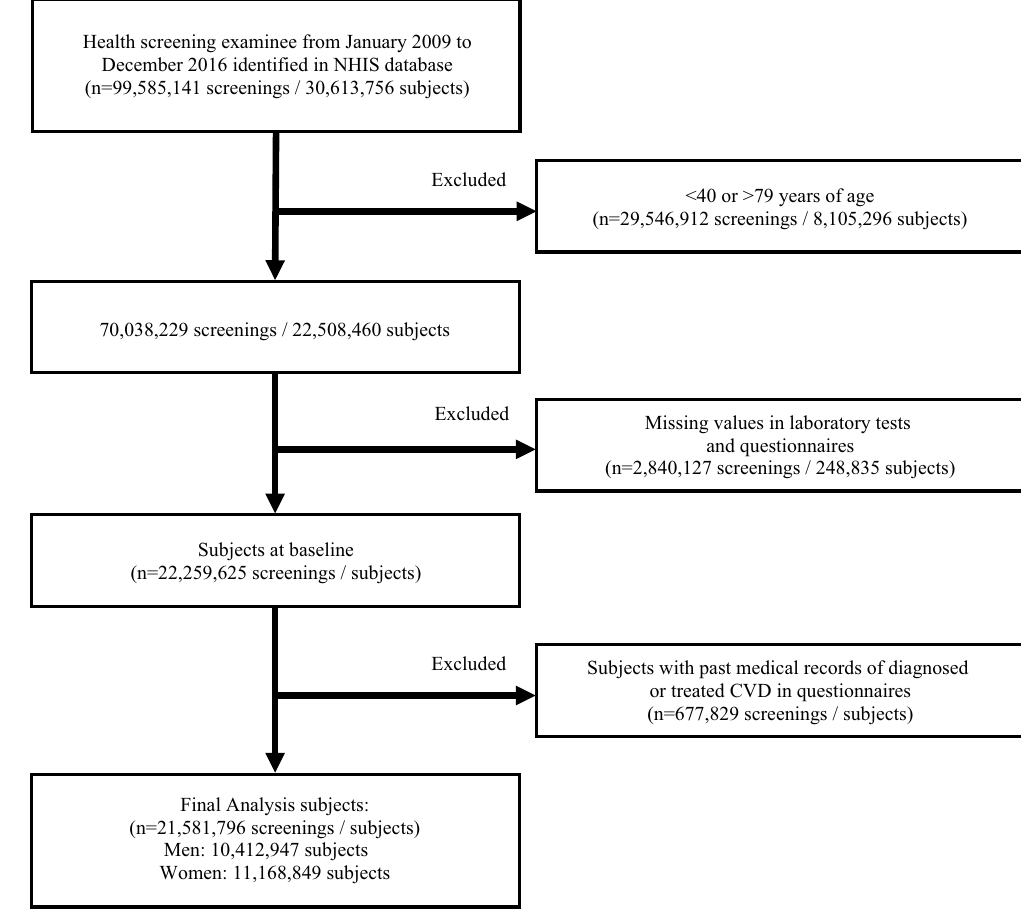
Figure 2. Defining the study